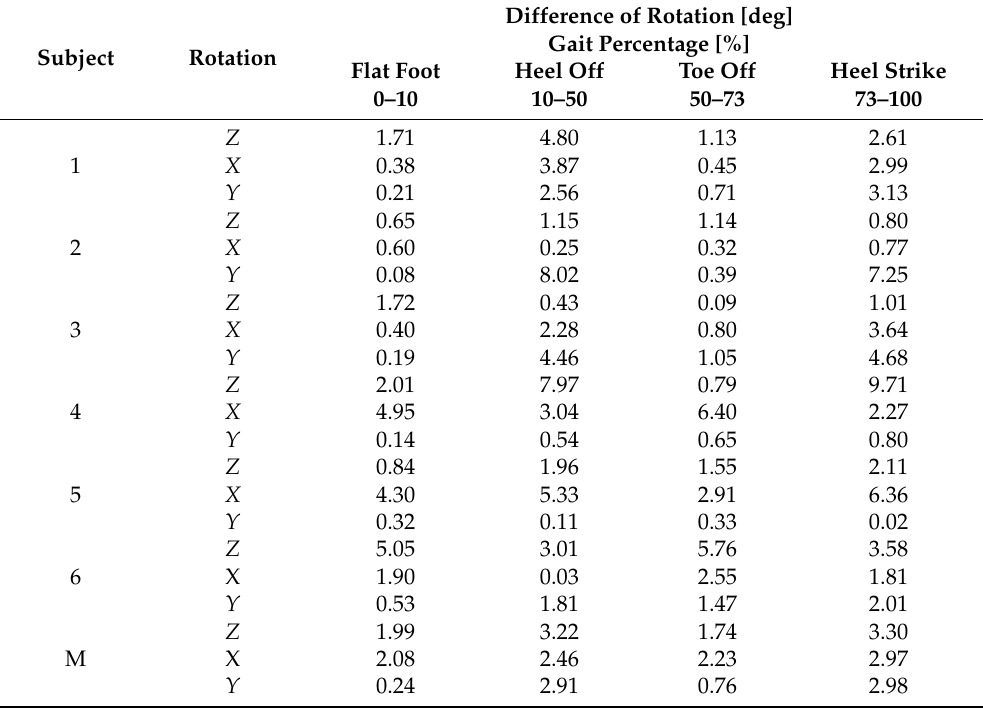
Table 4. Rotation range between gait sub-phases. The rotation difference is estimated according to the mean value at the corresponding gait percentage. Units in degrees. (M.: Mean). Difference of Rotation [deg] Gait Percentage [%] Subject Rotation Flat Foot Heel 0–10